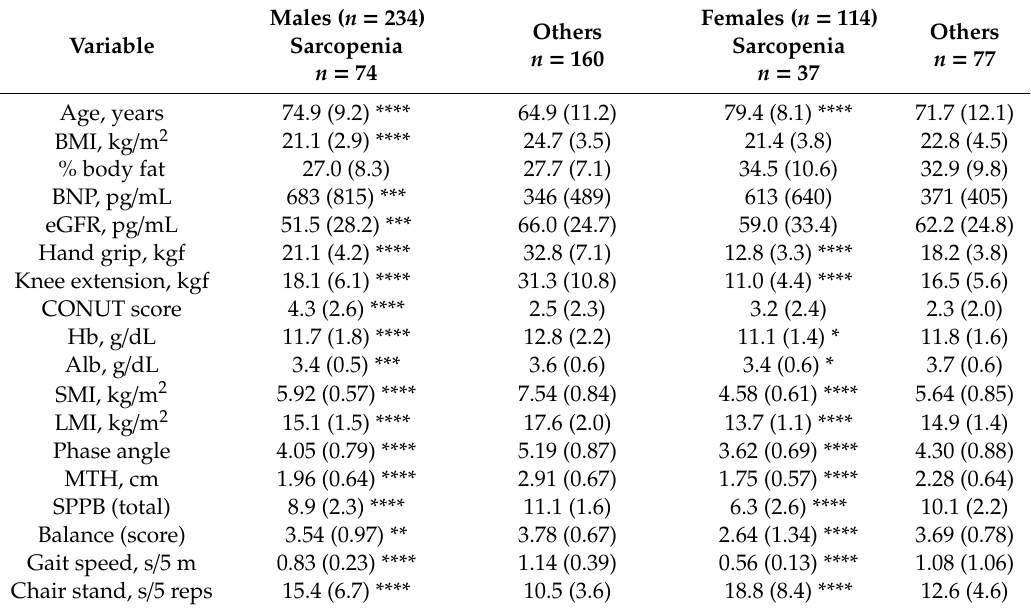
Table 4. Comparison of various parameters between patients with and without sarcopenia.